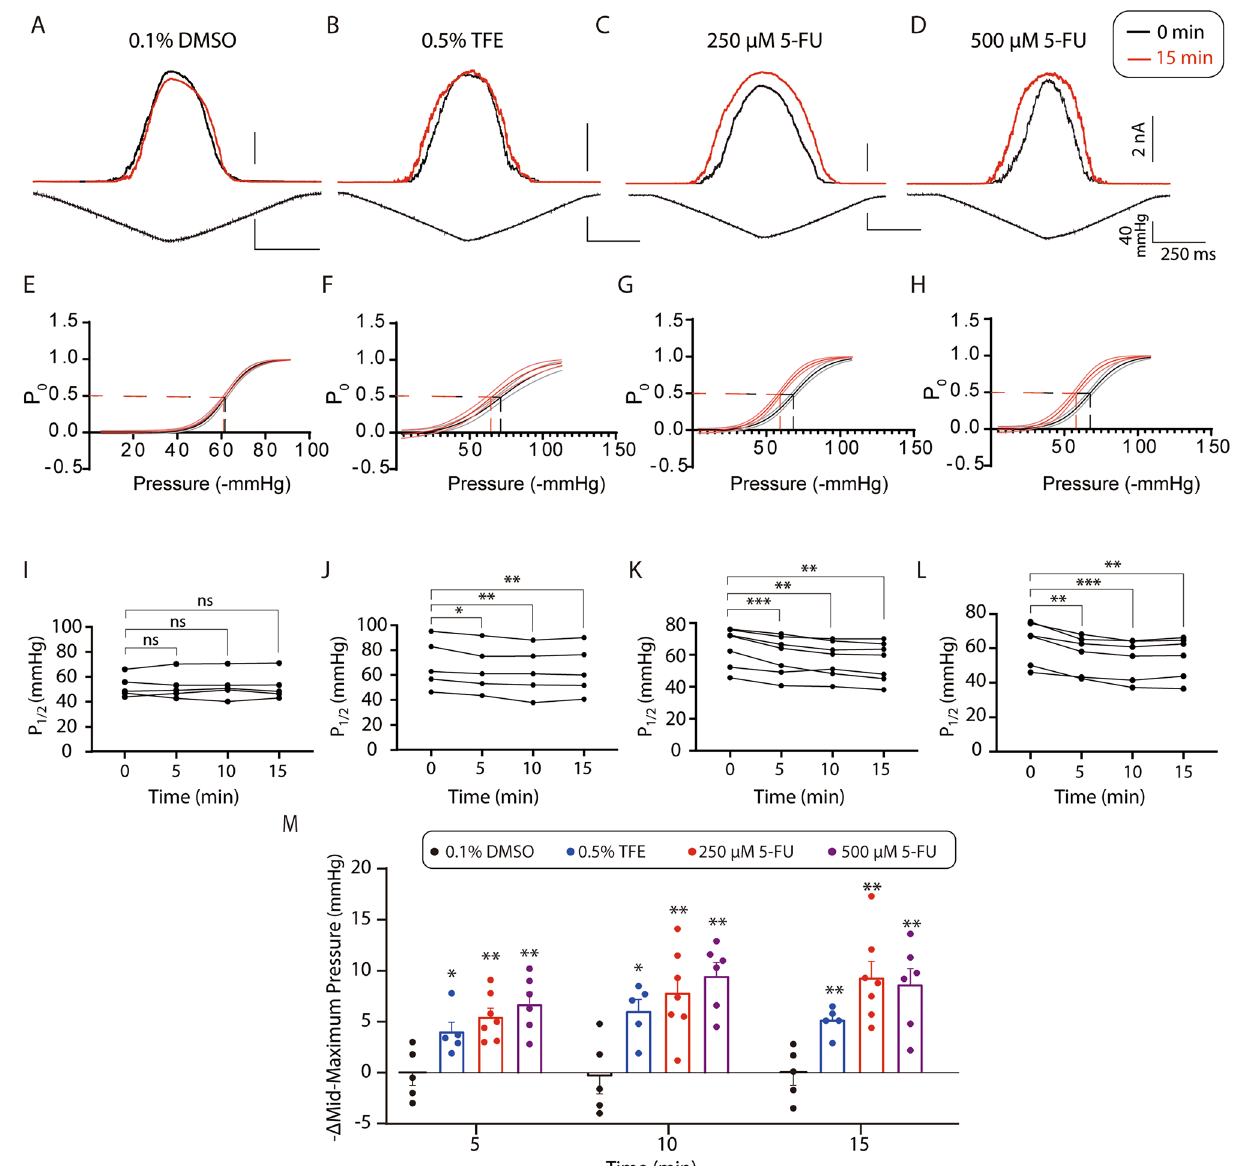
Figure 5. Effect of DMSO, TFE or 5-FU on gating of G22S-MscL reconstituted into liposomes. ( A )–( D ) Representative current traces showing activation of G22S-MscL channels upon application of pressure ramps recording under different conditions with and without application of 5-FU of TFE. The black traces indicate currents recorded before application of a drug, while the red traces indicate currents recorded at 15 min after exposure of the liposome patch to drugs. ( E – H ) Boltzmann distribution functions determined in the absence and the presence of each amphipath. 0.1% DMSO was used to dissolve 5-FU in the recording solution. Notice the parallel left-shift in negative pressure required for MscL-G22S gating in the presence of both TFE or 5-FU, but not in the DMSO control experiments. ( I )–( L ) Line charts showing the mid-maximum pressure (P 1/2 ) of recordings in ( A )–( D ). Different from 0 min, for 0.1% DMSO, ns P = 0.9071, ns P = 0.8023, ns P = 0.9210 and n = 5; for 0.5% TFE, * P = 0.0177, ** P = 0.0074, ** P = 0.0011 and n = 5; for 250 µM of 5-FU, *** P = 0.0008, ** P = 0.0029, **P = 0.0013 and n = 7; for 500 µM of 5-FU, ** P = 0.0018, ***P = 0.0008, ** P = 0.0044 and n = 6, at 5, 10 or 15 min after treatment. (M) Summary data of shifts of mid-maximum pressure. The shifts were calculated by subtracting mid-maximum pressure obtained at each time point from that obtained at 0 min. Different from DMSO control, for 0.5% TFE, * P = 0.0273, * P = 0.0133, ** P = 0.0037 and n = 5; for 250 µM of 5-FU, ** P = 0.0025, ** P = 0.0058, ** P = 0.0015 and n = 7; for 500 µM of 5-FU, ** P = 0.0020, ** P = 0.0010, ** P = 0.0032 and n = 6, at 5, 10 or 15 min after